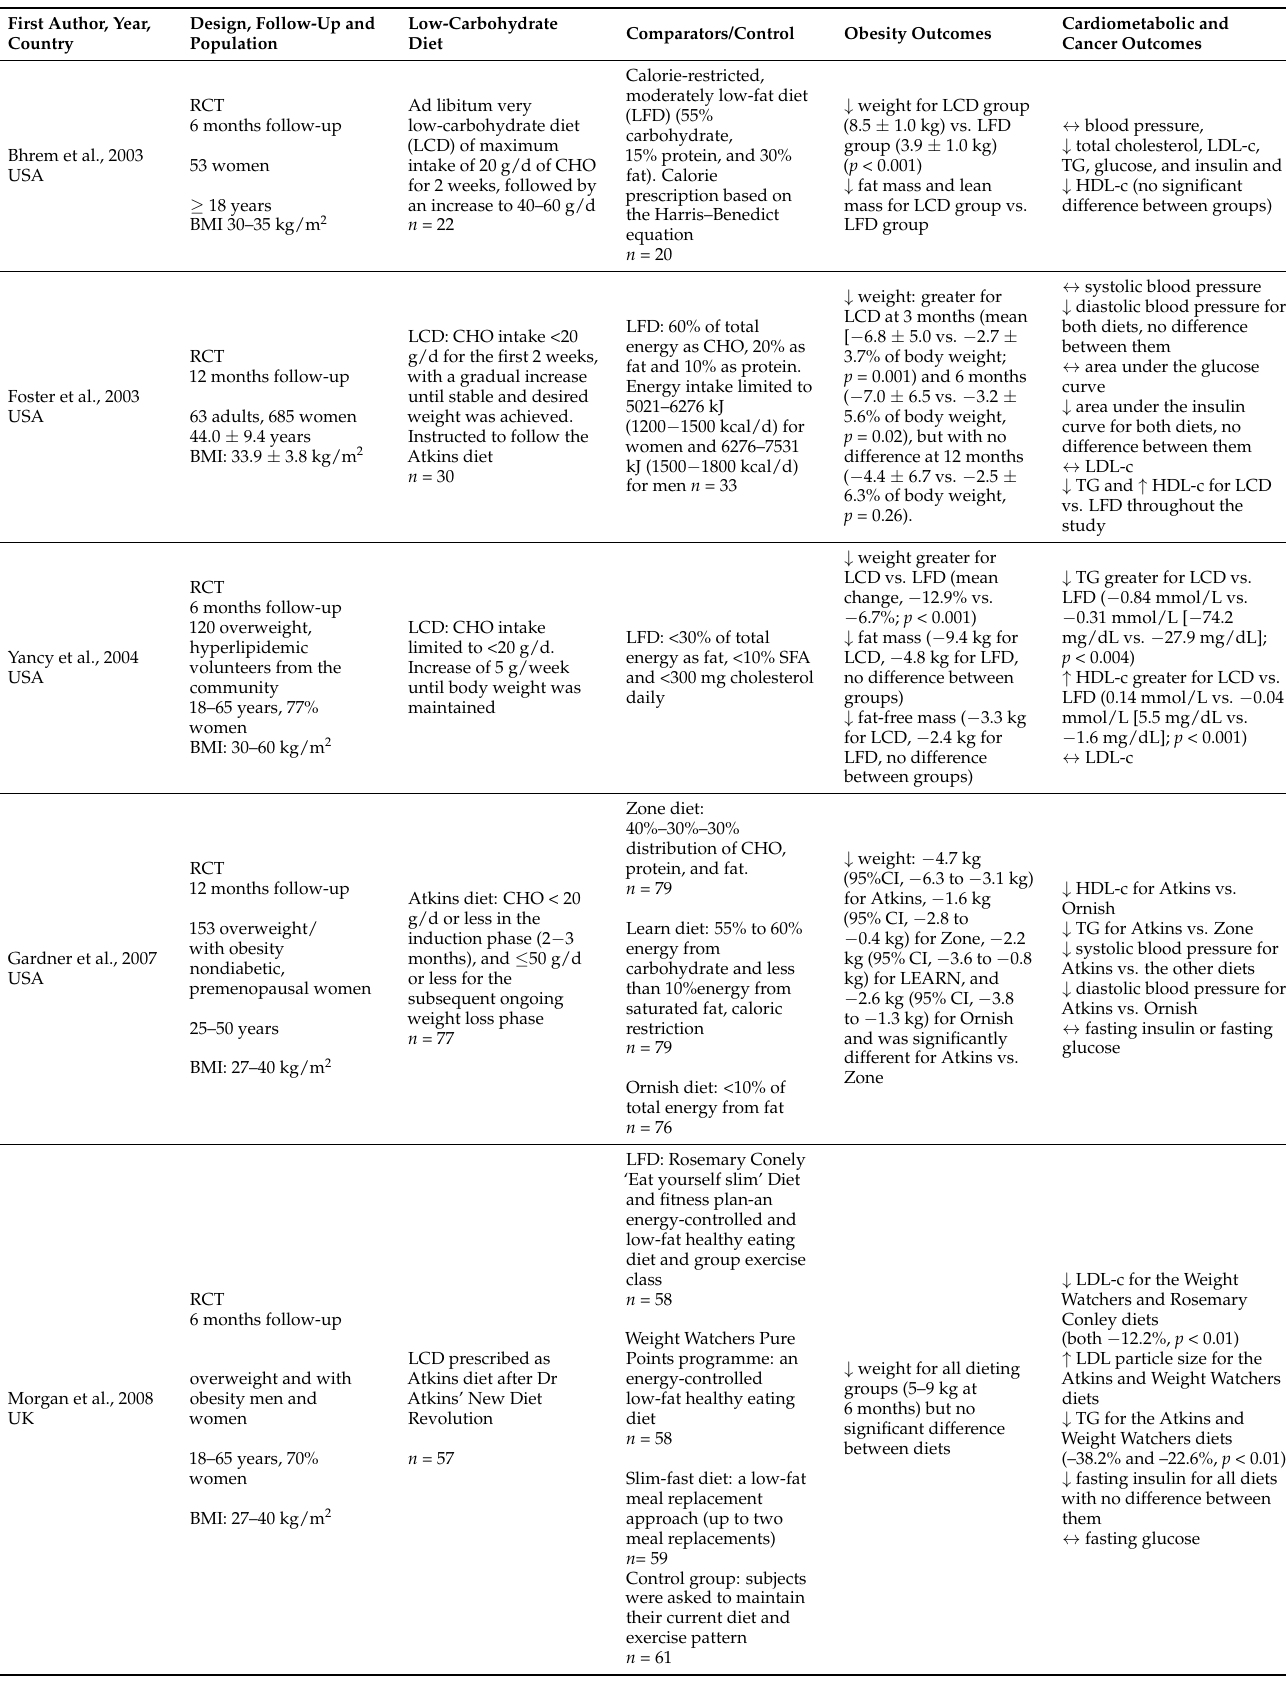
Table 1. Summary of studies with low-carbohydrate diets for weight loss, cardiometabolic and cancer